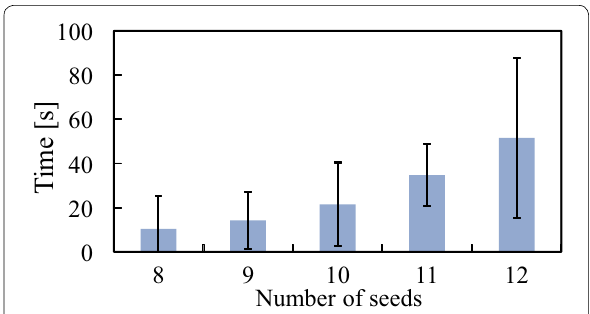
Fig. 8 Relationship between the number of seeds and time needed to align